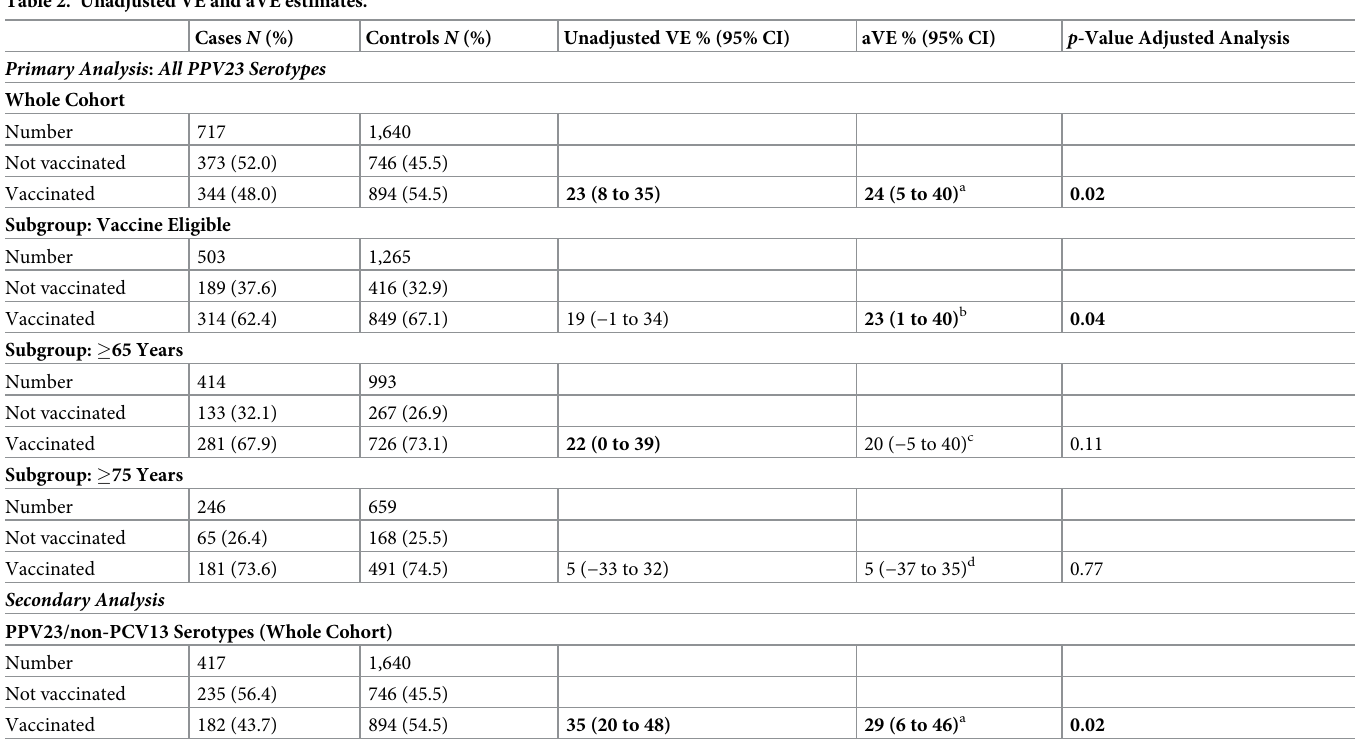
Table 2. Unadjusted VE and aVE